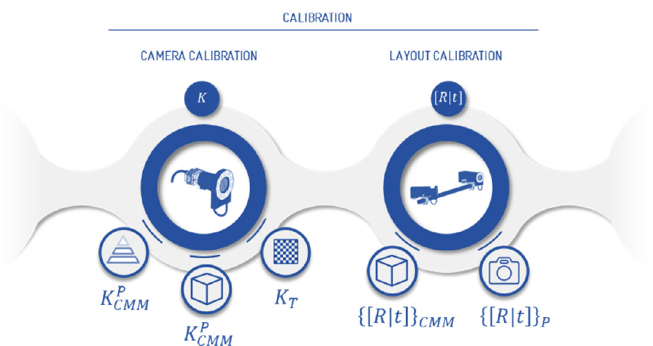
Figure 2. The calibration methodologies studied in this work for the camera calibration (intrinsic camera parameters) are a CMM virtual grid (pyramid/cube) and test-field calibrations, while for the layout calibration a CMM virtual grid (cube) and photogrammetry except for the flat intrinsic calibration pattern and the photogrammetry extrinsic calibration pattern, the rest of the experimental tests are executed in a CMM (ZEISS Prismo 0.9 + L/350 µm). The main goal is to obtain an accurate ground truth in the final verification to determine the error budgeting of the system. More specifically, they have been verified in two measurement scenarios to evaluate the different factors of each calibration process.